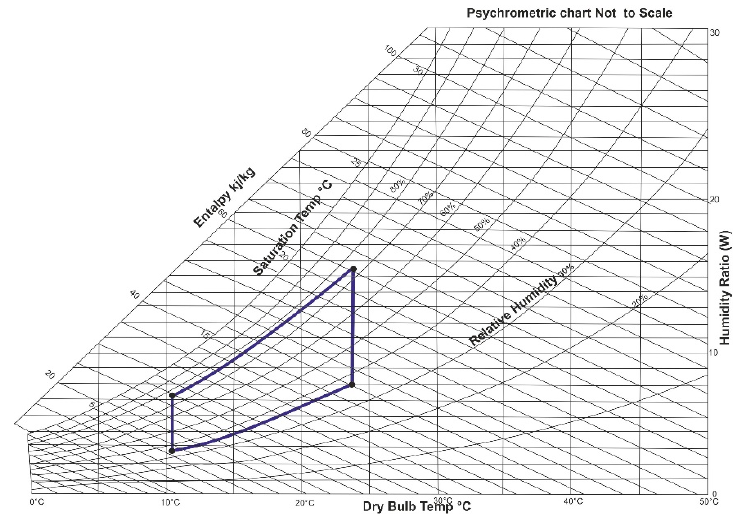
Figure 6. Psychrometric zone of opportunity for the use of atmospheric water generator (AWG) in Matehuala, SLP, Mexico.